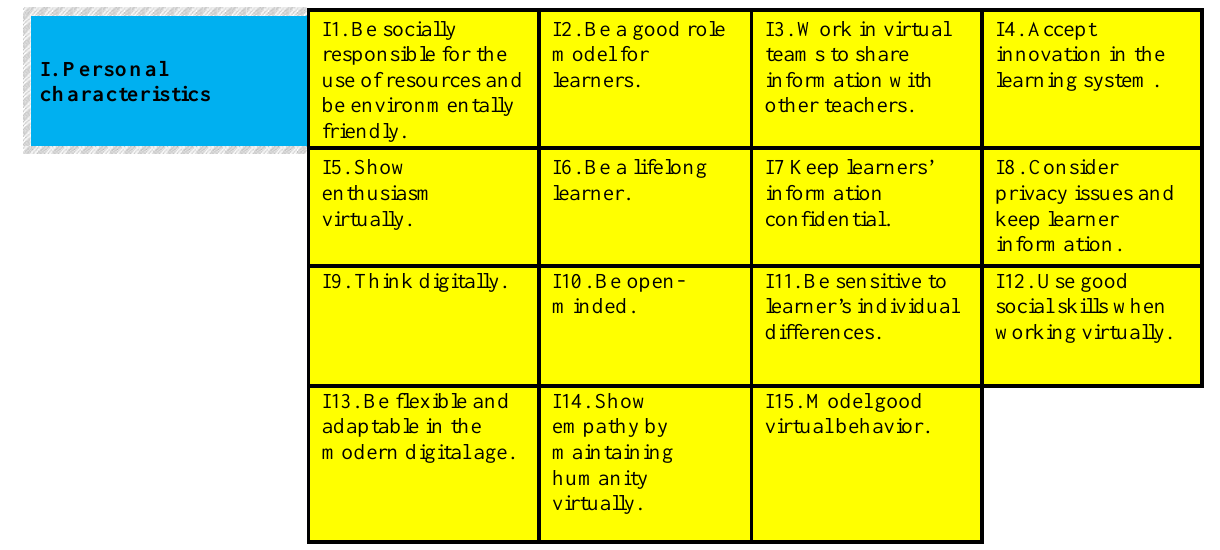
Figure 11. Digital teacher personal